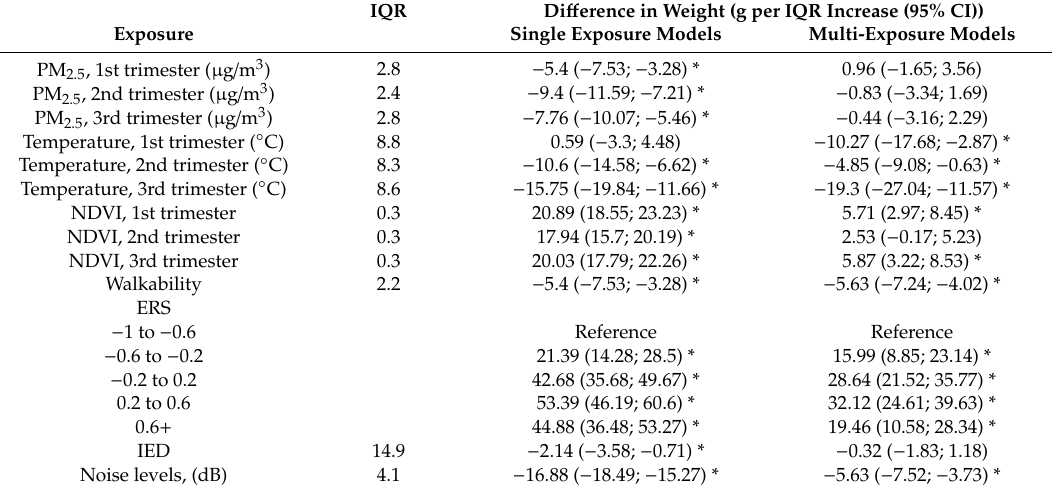
ERS = Economic Residential Segregation; IED = Index of Economic Dissimilarity; NDVI = normalized difference vegetation index. * p < 0.05.